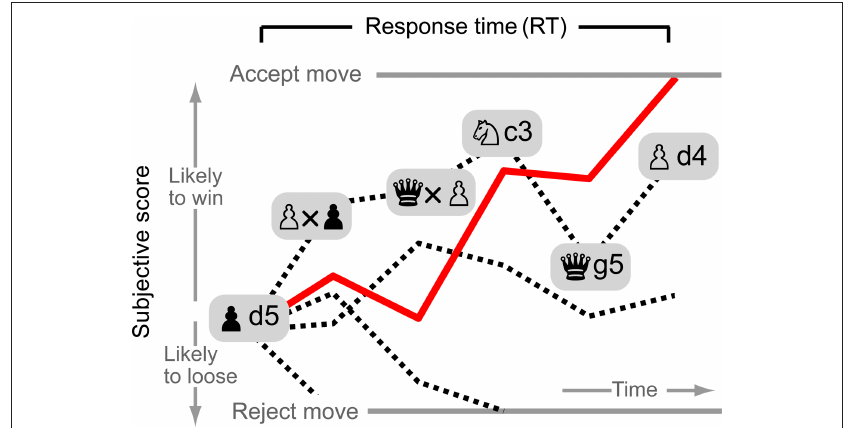
Figure 1 | A decision mechanism in chess. After an opponent’s move (d5), a player evaluates his choices by assigning a goodness value (subjective score) to each possible response. He must then calculate how the score will change after a sequence of moves involving the most likely opponent’s responses. When accumulated score, that is, the summed value of each move within a sequence, reaches an acceptance criterion, the move initiating the sequence is played on the board. Deeper calculations, at the expense of longer response times, could be achieved by elevating the acceptance criterion. How the human brain assigns values to chess moves is still largely unknown, but in addition to raw piece value, its evaluation function likely incorporates variables such as elapsed time (Churchland et al., 2008), long term plans, and the opponent’s estimated